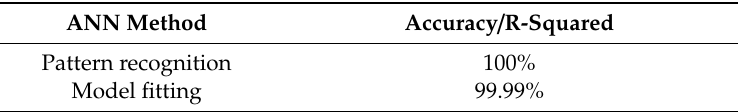
Table 3. Summary of fault detection and diagnostic by ANN.